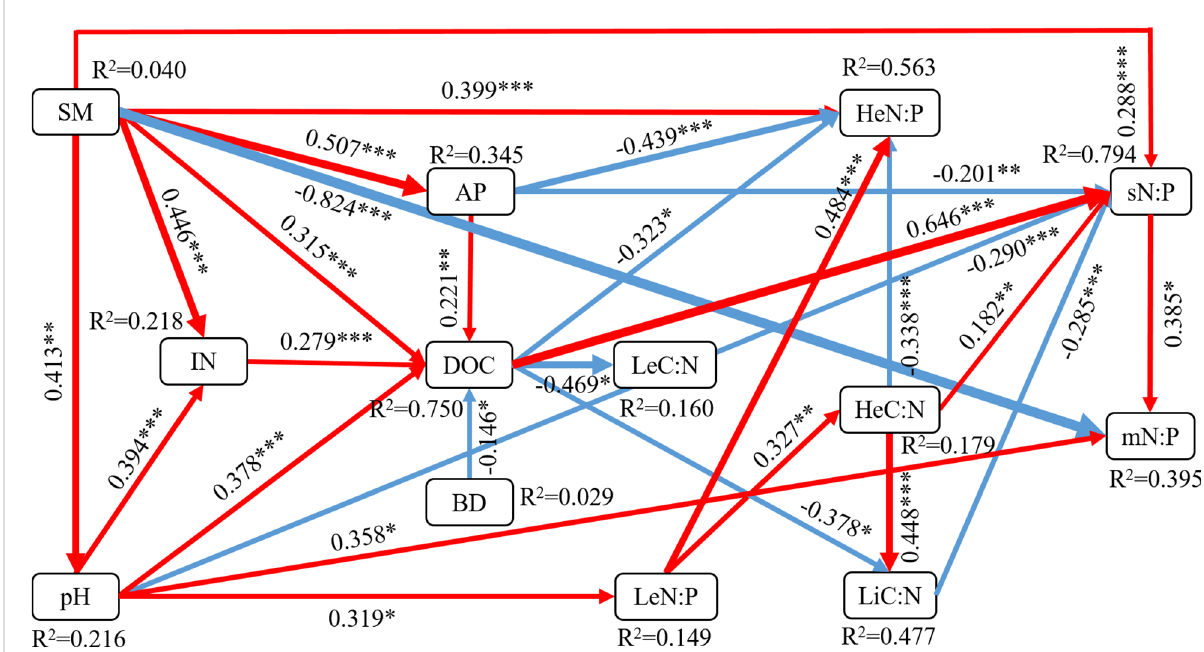
FIGURE 4 Structural equation modeling (SEM) analysis of the effects of soil physicochemical properties on the plant-soil-microbe C – N – P stoichiometry. Results of model fi tting: c 2 = 0.004, df = 1, P = 0.953, GFI = 1.000, AGFI = 0.999, CFI = 1.000, RMSEA = 0.000. Numbers on arrows are standardized path coef fi cients. Red and blue arrows indicate positive and negative effects, respectively, with the thickness representing the extent of in fl uence. R2 values represent the proportion of the variance explained for each endogenous variable. SM, soil moisture content; IN, inorganic N (NH4+-N and NO3¯-N); AP, available phosphorus; BD, soil bulk density; DOC, dissolved organic carbon; Le, Sophora moorcroftiana leaf; He, understorey herb biomass; Li, litter; s, soil; m, microbial biomass. Signi fi cance levels are as follows: *P < 0.05, **P < 0.01, and ***P <